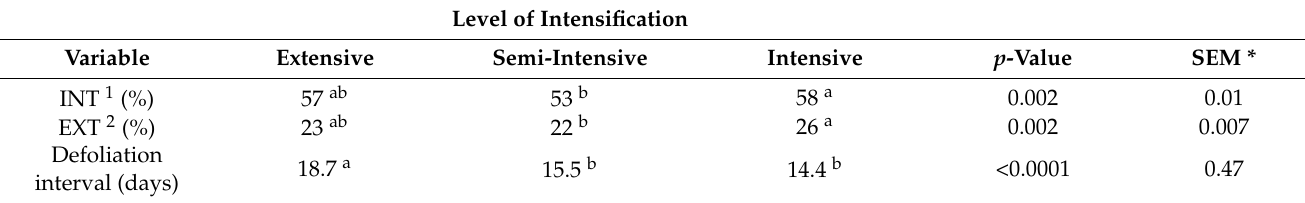
Table 4. Defoliation intensity of leaf blades, removal intensity of extended tillers, and defoliation interval of marandu palisadegrass ( Urochloa brizantha ‘Marandu’) pastures under different levels of pasture intensification. Level of